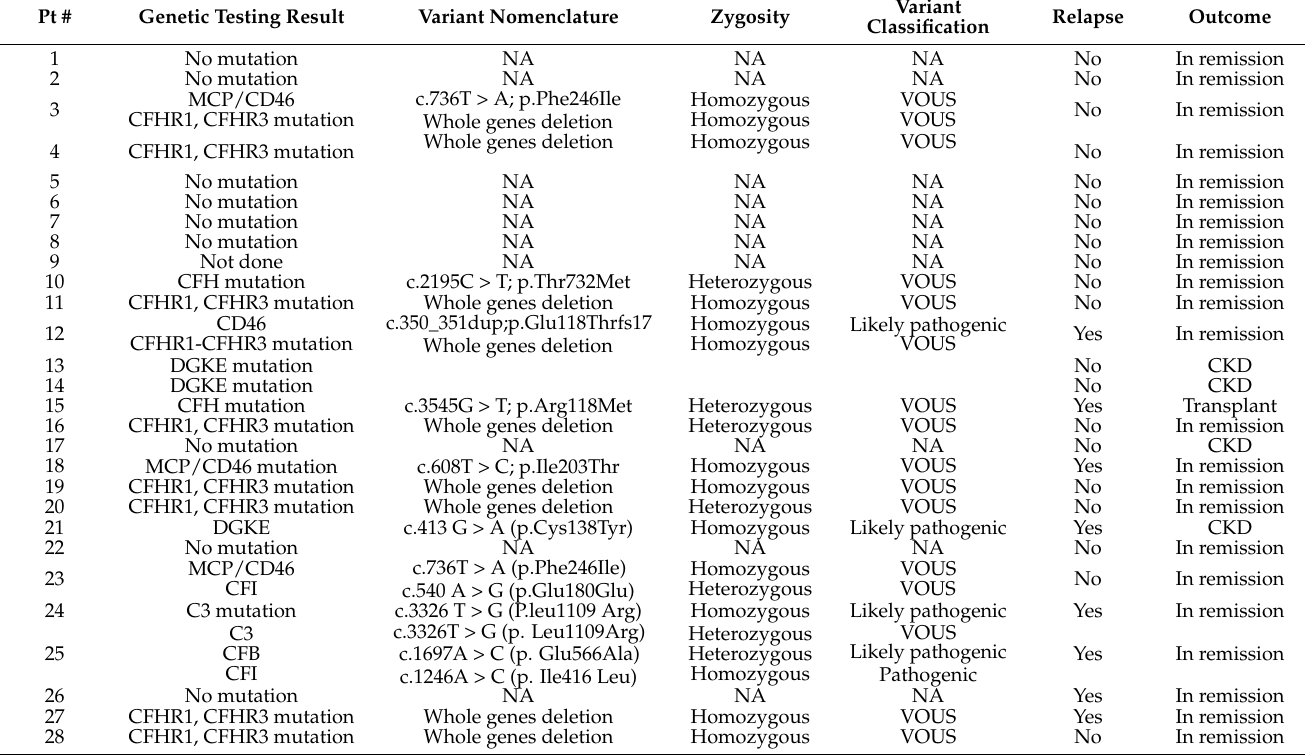
Table 2. Genetic variants of the